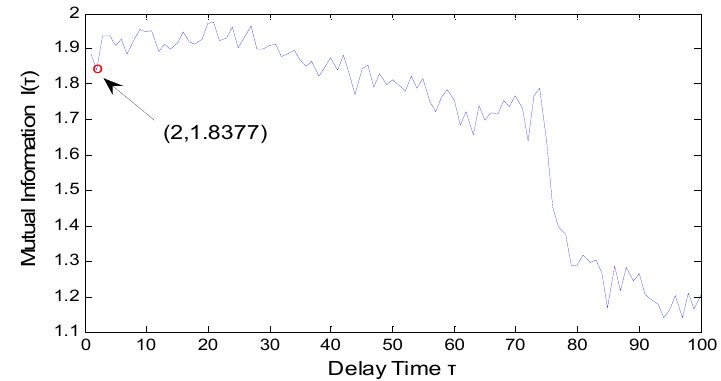
Figure 4. Mutual information I ( τ ) of different τ for BOD dataset.